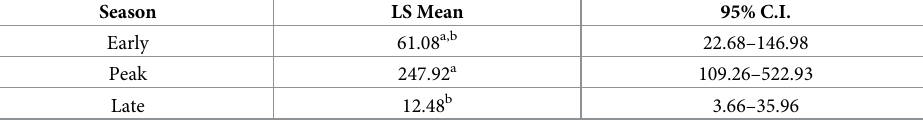
Table 3. Least square means with confidence intervals for New Jersey bottle rotator trap counts of all Aedes albo- pictus at two study sites over three seasons (early, peak, and late) and over a 24 hr period.